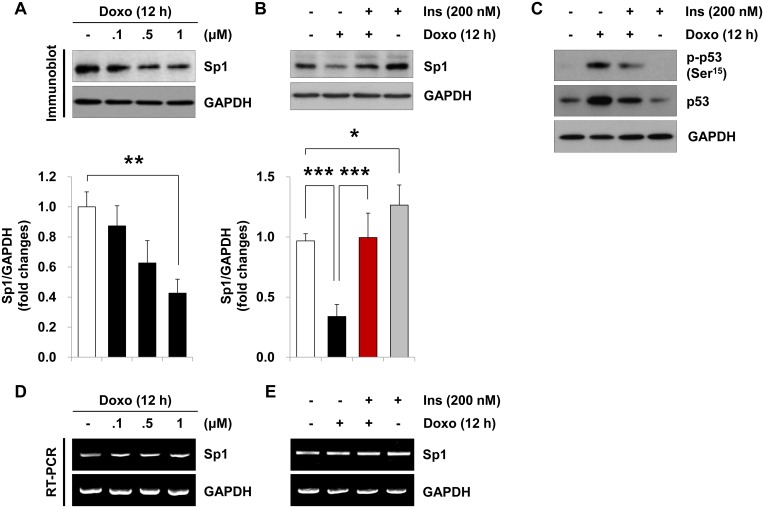
Effect of insulin on the doxorubicin-induced changes in Sp1 and p53.(A, D) H9c2 cardiac myocytes were left untreated or treated with the indicated concentration of doxorubicin (Doxo) for 12 h, and (B, C, E) serum-deprived cells were left untreated or pretreated with insulin (200 nM) for 1 h prior to treatment with doxorubicin (1 μM) for 12 h. Whole cell lysates were analyzed by immunoblotting with anti-Sp1, anti-phospho-p53 (Ser15), anti-p53 and anti-GAPDH antibodies. Graphs represent the mean ±S.D. of the normalized densitometric analyses of Sp1 protein levels (A, **p < 0.01, n = 3; B, ***p < 0.001, n = 5). (D, E) Sp1 mRNA amount was determined by RT-PCR (28 cycles). Note that the blots in panel C represent one of three independent experiments.